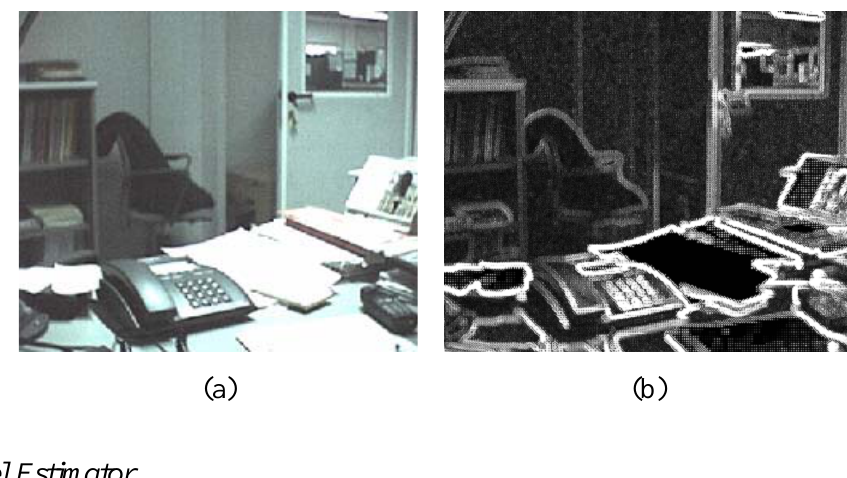
Figure 7: bright pixels are associated to high texture, dark pixels to flat areas. Figure 7. Texture Analyzer output: (a) input image after colour interpolation (b) gray-scale texture degree output: bright areas correspond to high frequency, dark areas correspond to low